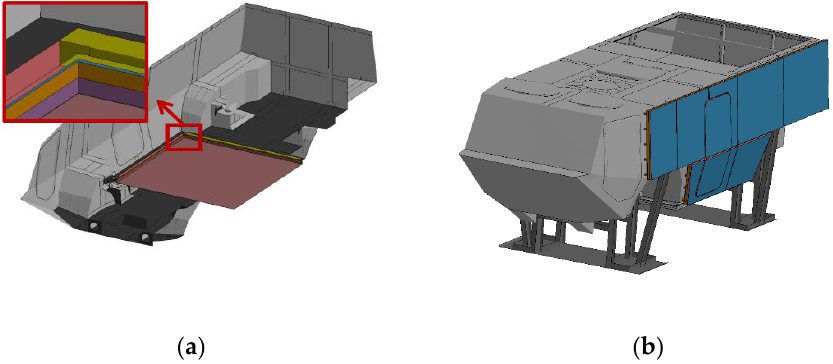
Figure 6. The vehicle with the mounted protective system: ( a ) for the explosion under the vehicle, ( b ) for the explosion next to the vehicle.